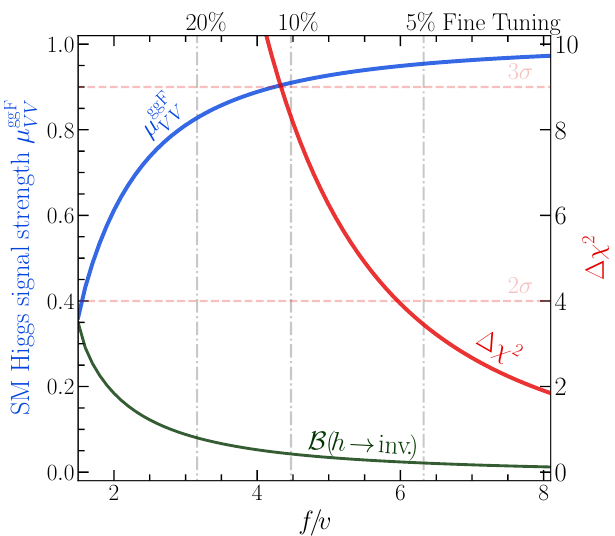
Figure 7 . In this plot we summarize our results for the global (cid:12)t of the SM Higgs data from LHC Run-2 as a function of f=v . The blue curve shows the SM Higgs signal strength measurement (cid:22) ggF V V with the markers on the left y-axis, and the red curve shows the (cid:1) (cid:31) 2 (cid:12)t values to the SM Higgs signal strength measurements with the markers on the right y-axis. The green curve shows the SM Higgs invisible branching fraction ( h inv : ), i.e. the SM Higgs decays to the twin sector B ! (markers are w.r.t. left y-axis). We also show with dashed light-red 2 (cid:27) and 3 (cid:27) lines for the (cid:1) (cid:31) 2 (cid:12)t to the Higgs data. The dash-dotted vertical lines show the estimated (cid:12)ne tuning required in the twin Higgs